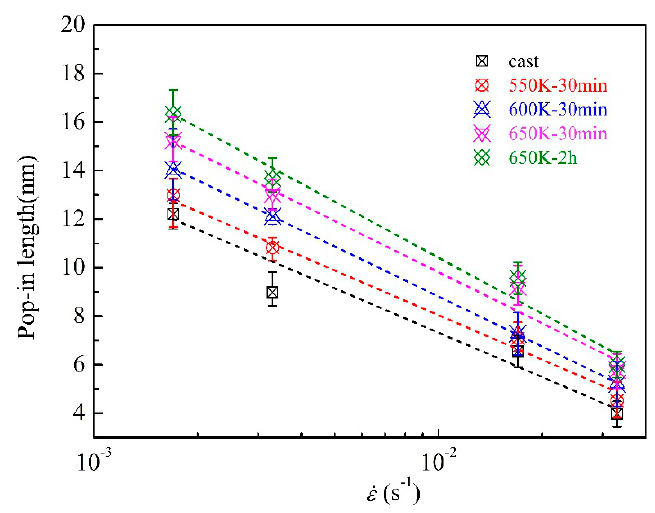
Figure 4. The variation of pop-in lengths with strain rates for various structural states.